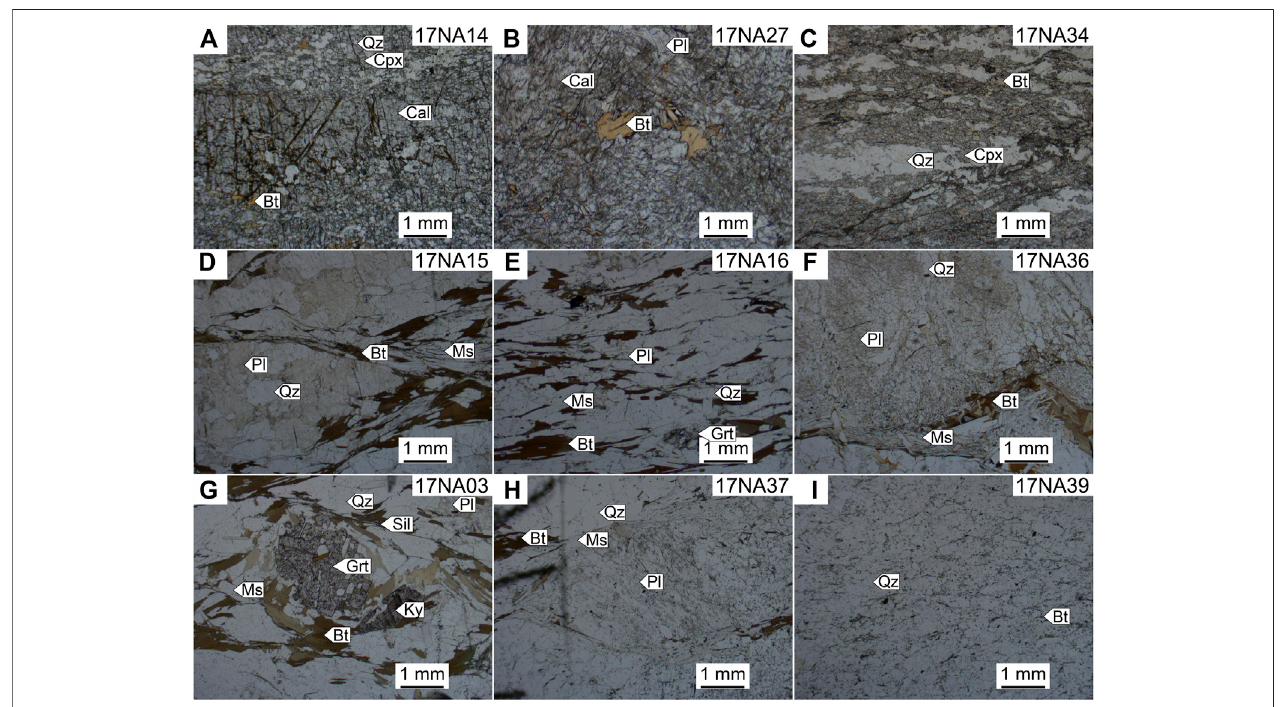
FIGURE 4 | Photographs of samples in the microscope. (A – C) Calc-silicate samples contain ferromagnesian minerals such as diopside, indicating protolith contains ma fi c source; (D – G) schist and paragneiss samples contain garnet, plagioclase, biotite, muscovite, and quartz; (H) orthogneiss contains Augen plagioclase surroundedbymuscoviteandbiotite; (I)